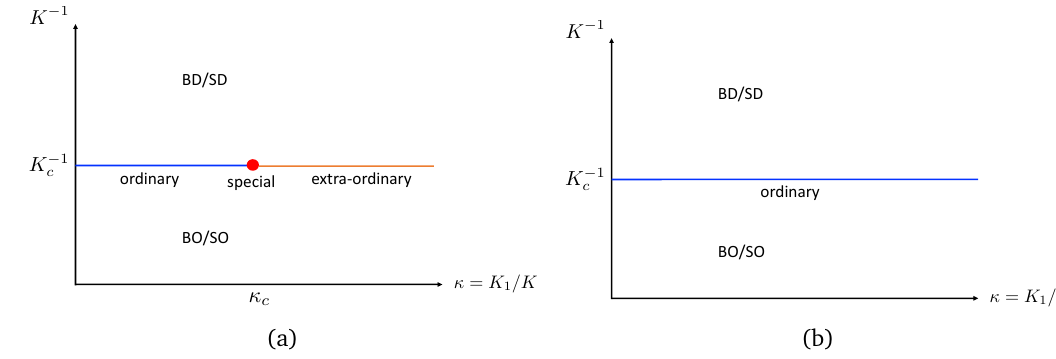
Figure 2: Possible boundary phase diagrams of the classical O ( N ) model for d = 3 and N > 2. Ref. [ 31 ] argued that the phase diagram on the left is realized for 2 < N < N with the extraordinary phase being of the “extraordinary-log" character, while the phase diagram on the right is realized for large N . Here N critical value of N . See Ref. [ 31 ] for scenarios for the evolution of the phase diagram from one on the left to one on the right with increasing N